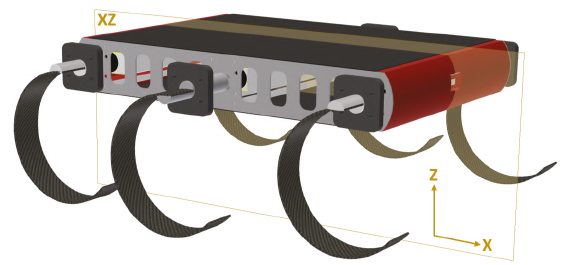
Figure 1. Sagittal plane of the CLHeRo.